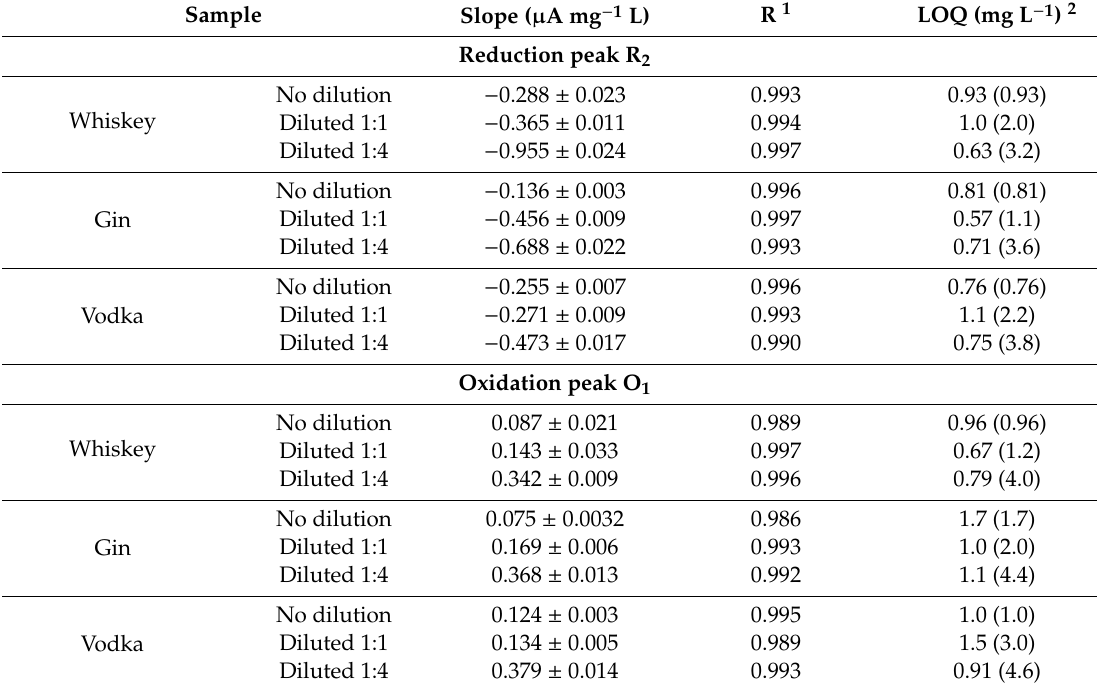
Table 1. Calibration features in pooled spirit samples using the reduction peak R 2 and the oxidation peak O 1 .